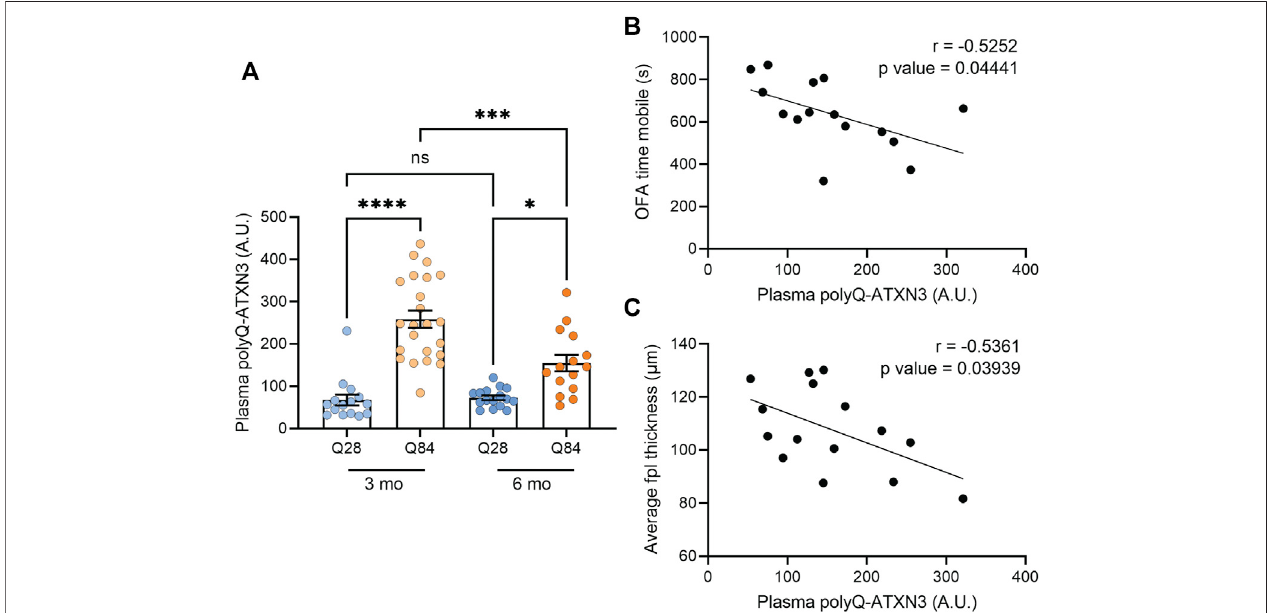
FIGURE 5 | Higher polyQ-ATXN3 levels correlate with decreased mobility and a thinner molecular layer in SCA3 mice. (A) PolyQ-ATXN3 levels as measured by immunoassay in the plasma of Q28 and Q84 mice at 3 and 6 months of age. Error bars are the SEM. * p ≤ 0.05, ** p ≤ 0.01, *** p ≤ 0.001, **** p ≤ 0.0001, ns = non- signi fi cant (1-way ANOVA with Tukey ’ s multiple comparisons test). (B) Correlation analysis between plasma polyQ-ATXN3 levels and the time spent mobile in the open fi eld assay for6-month-old Q84 mice.Pearson ’ scorrelation coef fi cient(r) and p values areindicated. The linerepresentsan estimated simplelinearregression. (C) Correlation analysis between plasma polyQ-ATXN3 levels and the cerebellar molecular layer thickness at the posterolateral fi ssure (fpl) for 6-month-old Q84 mice. Pearson ’ s correlation coef fi cient (r) and p values are indicated. The line represents an estimated simple linear regression.